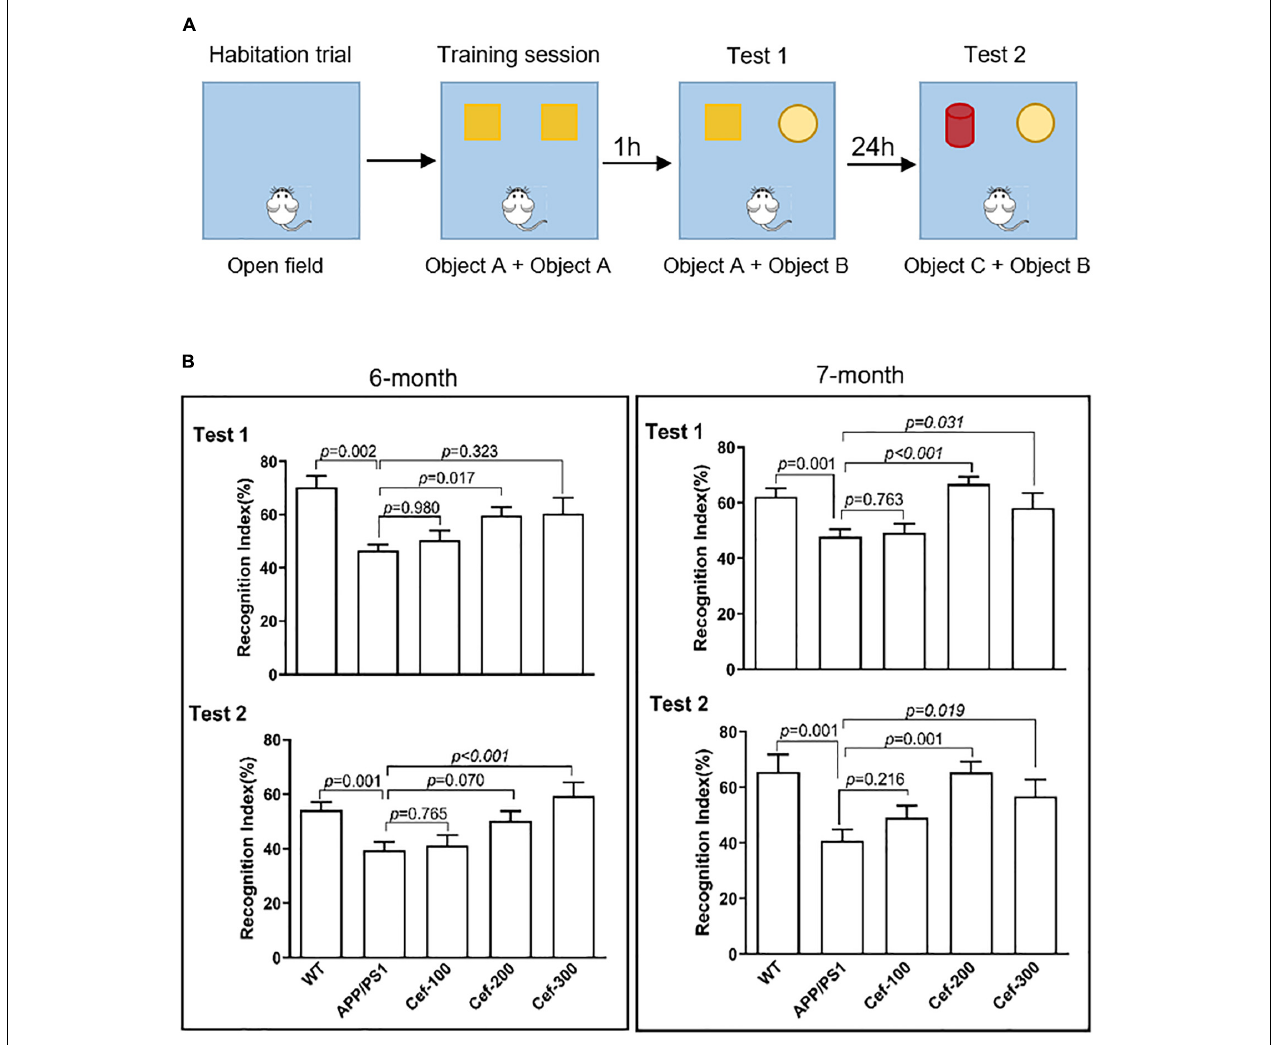
FIGURE 1 | Cef improves recognition memory deficits in 6-month and 7-month-old APP/PS1 mice. (A) Shows the protocol of novel object recognition test. (B) Shows the recognition index of the tests in 6-month and 7-month-old APP/PS1 mice in each group. The number of mice for each group are shown in Table 1 . WT, wild type; Cef, ceftriaxone. The italic values upon the bars are statistical P values.